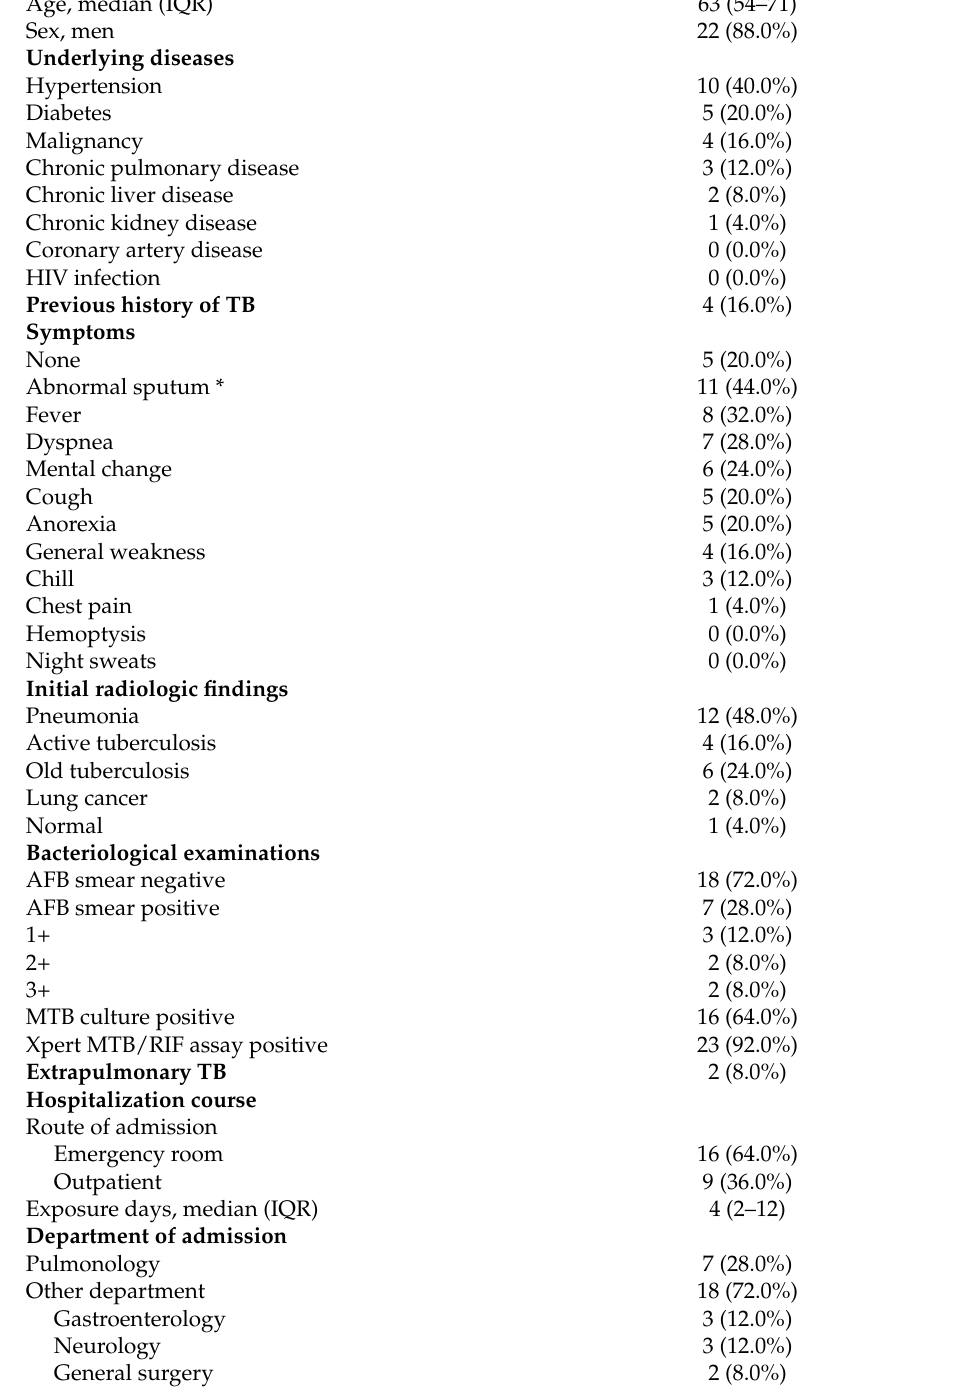
Table 1. Baseline characteristics of index patients (N =